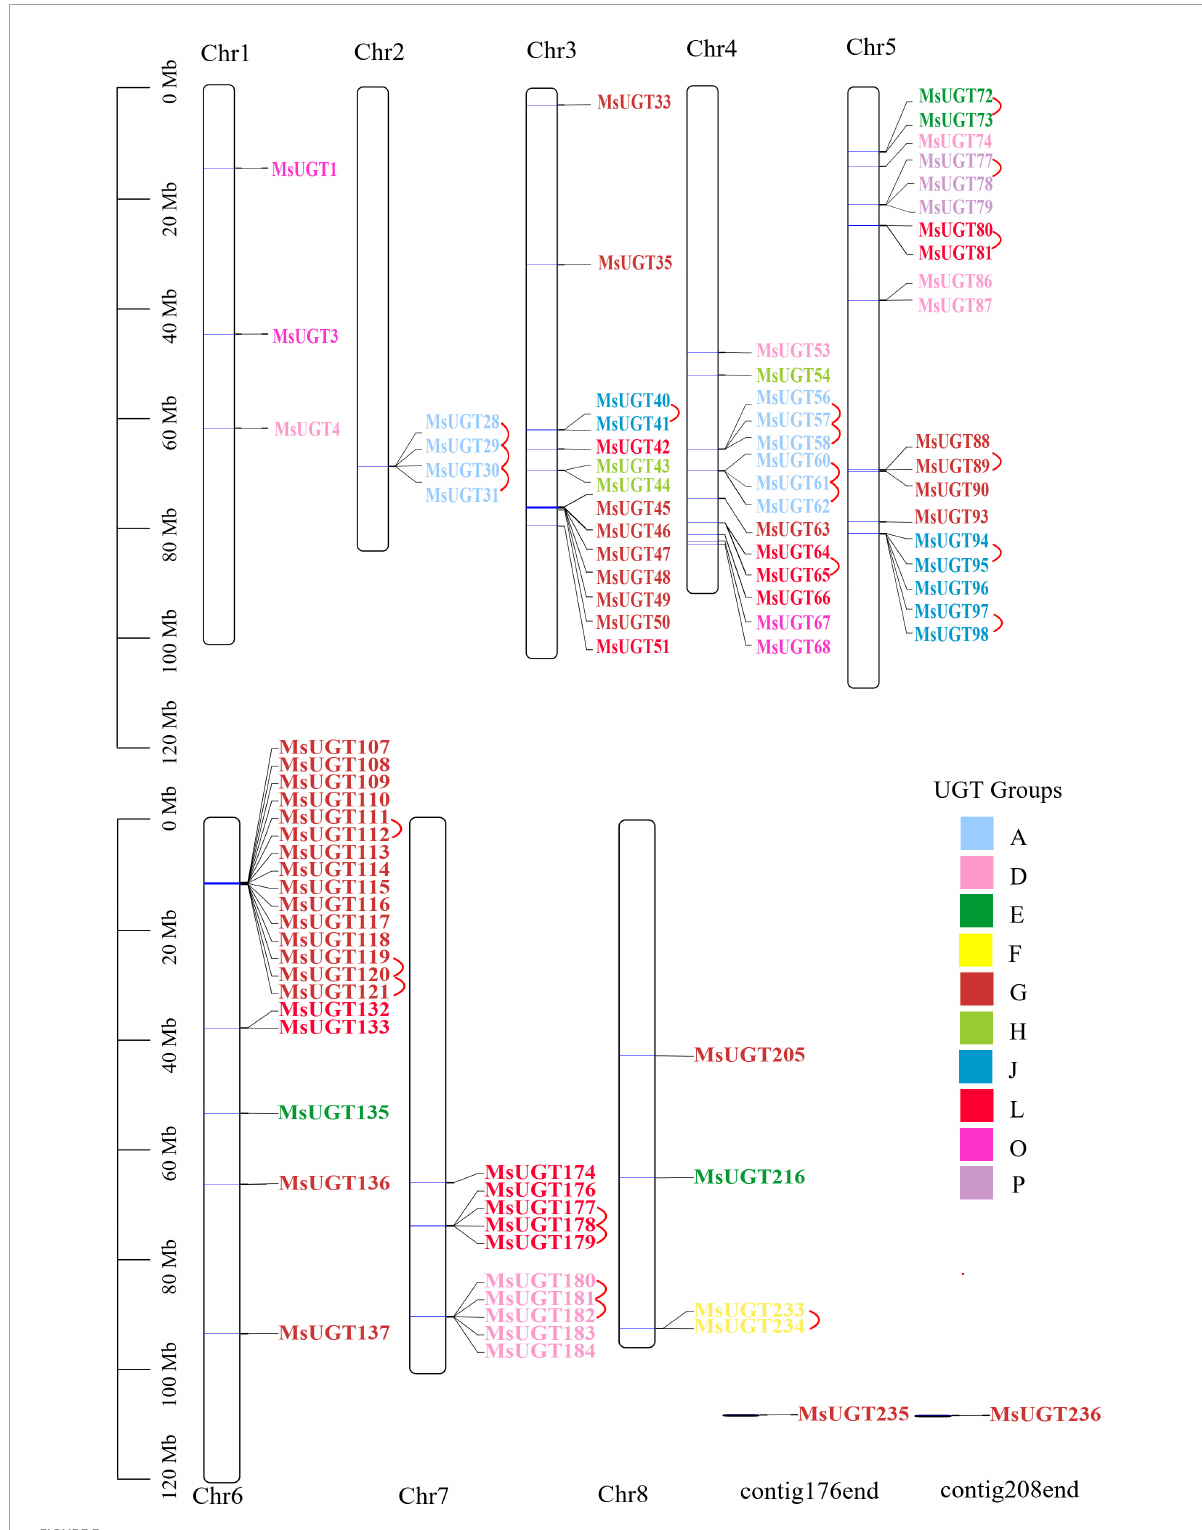
FIGURE3 Chromosomal location and tandem duplication event analyses of MsUGT genes associated with secondary metabolism in alfalfa. The tandem duplicated gene pairs are connected by red lines. Each phylogenetic group is indicated by the same color used in the evolutionary tree in Figure 2A